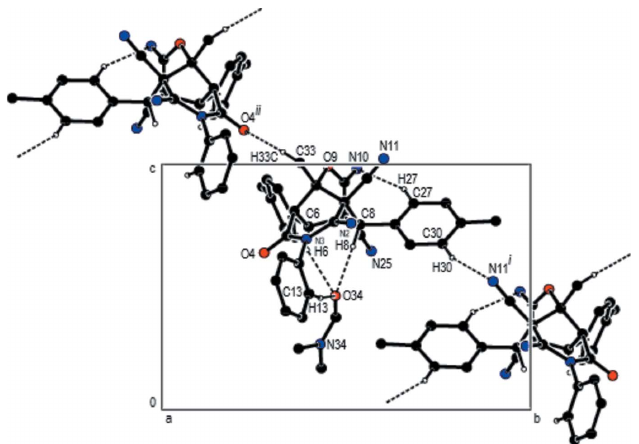
Figure 4 A partial view of the crystal packing along the a axis of the title compound with C—H (cid:2)(cid:2)(cid:2) O and C—H (cid:2)(cid:2)(cid:2) N hydrogen bonds indicated (dashed lines). [Symmetry codes: (i) x , (cid:5) y + 1 A Hirshfeld surface analysis was performed to quantify the intermolecular interactions; the accompanying two-dimen- sional fingerprint plots were obtained using CrystalExplorer17 (Turner et al. , 2017). The Hirshfeld surface mapped over d using a standard surface resolution with a fixed colour scale of (cid:5) 0.1713 (red) to 1.4361 (blue) a.u. is shown in Fig. 6. The shorter and longer contacts are indicated as red and blue spots, respectively, on the Hirshfeld surfaces, and contacts with distances approximately equal to the sum of the van der Waals